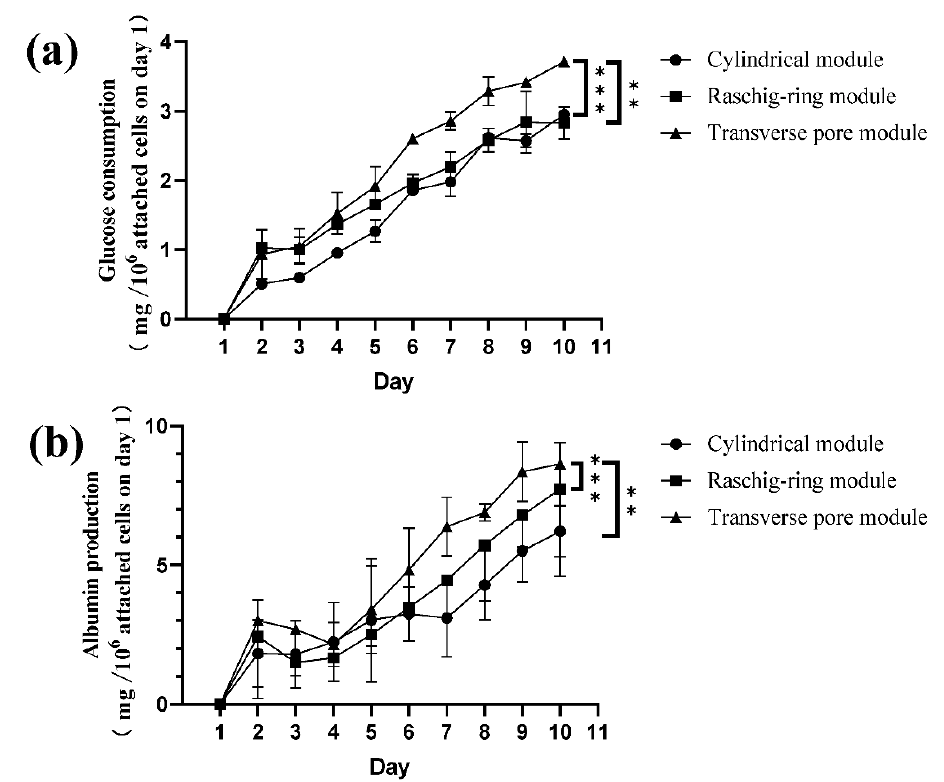
Figure 6. ( a ) Glucose consumption and ( b ) albumin production of Hep G2 cells in three types of modules. Each point represents mean ± SD (n = 2 independent experiments). ** P < 0.01, *** P < 0.005.